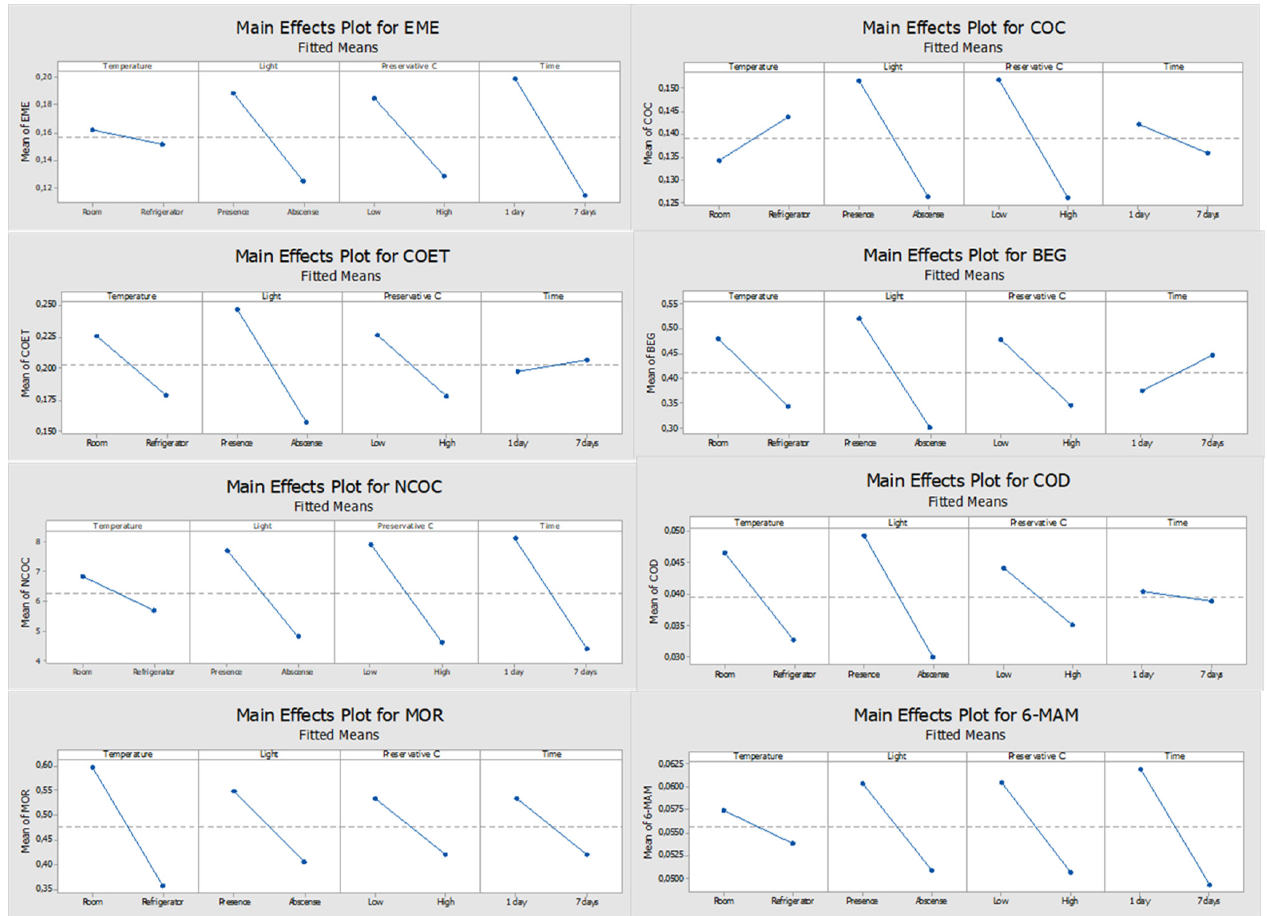
Figure 4. Main effects plots of the compounds when sodium fluoride was used as the preservative; The slope of the lines represents the effect of the response for the factors under study: temperature (room or refrigerator (4 °C)), light (presence or absence), preservative concentration level (low or high), and storage time (1 or 7 days).